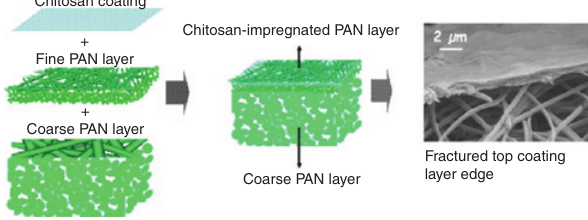
Figure 15: Fabrication schematics of the electrospun scaffold with a coating layer. SEM image represents the fractured composite membrane containing PAN nanofibrous scaffold (with 4 ~ 12 wt% sequential electrospinning) and chitosan coating. For details, see Ref. [56]; reprinted with permission from